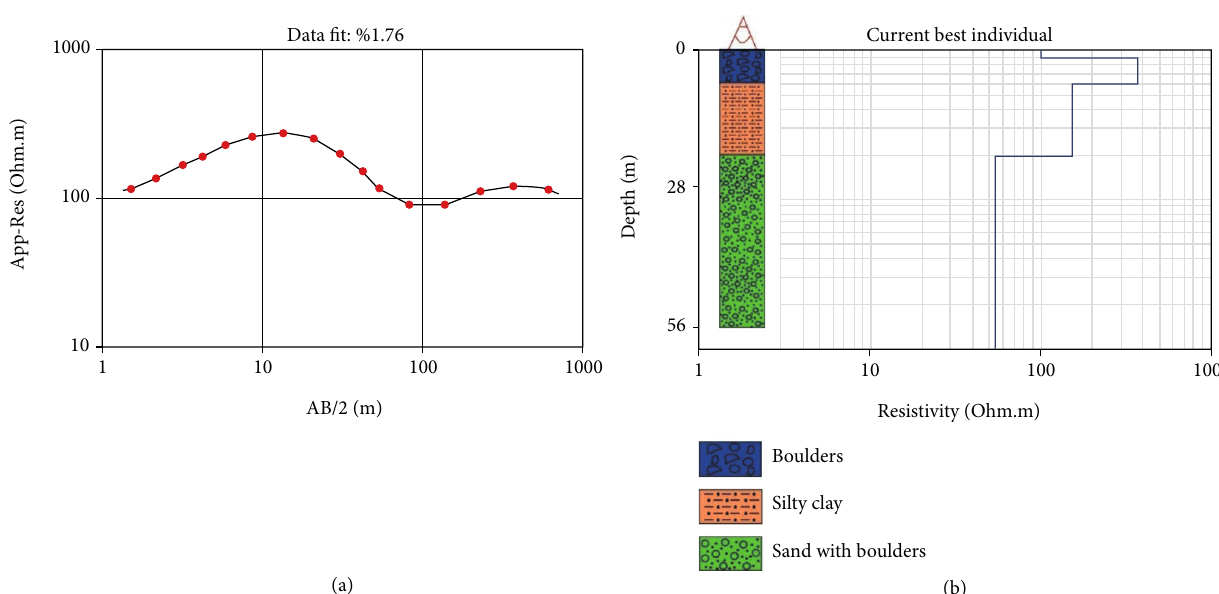
Figure 5: (a) The VES point (E5) acquired in the northeastern part of the study area. The best fi t characteristic inversion curve (black line) is drawn on the acquired subsurface resistivity data points highlighted with red dots. (b) Brehole (BH-10) drilled nearby the E5 shows three main lithologies in the subsurface. The blue curve is the inversion of the resistivity points that also indicate generalized subsurface layers with